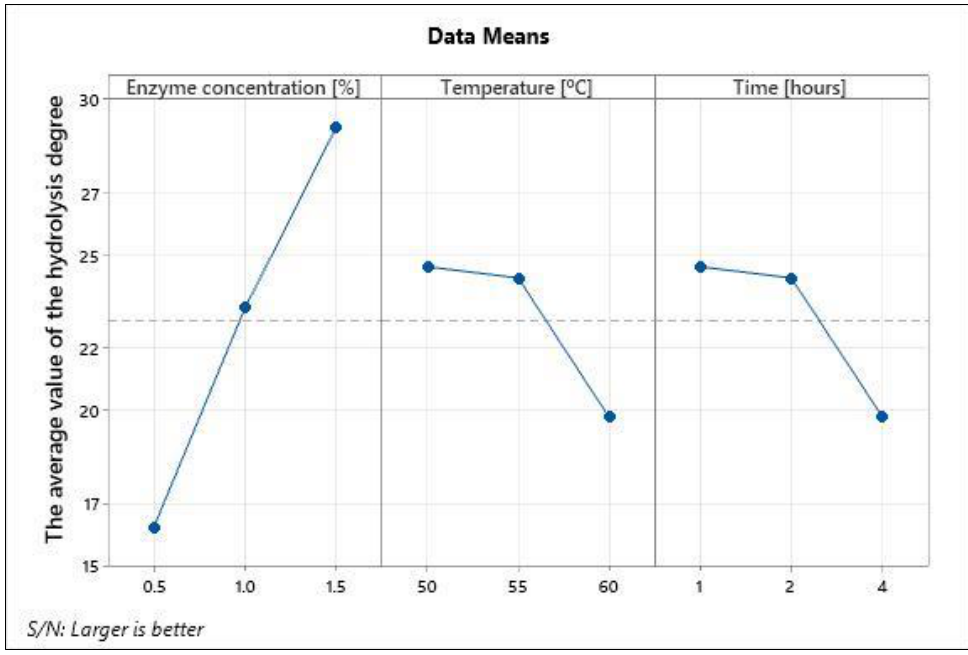
Figure 2. Main effects plot for S/N ratios.